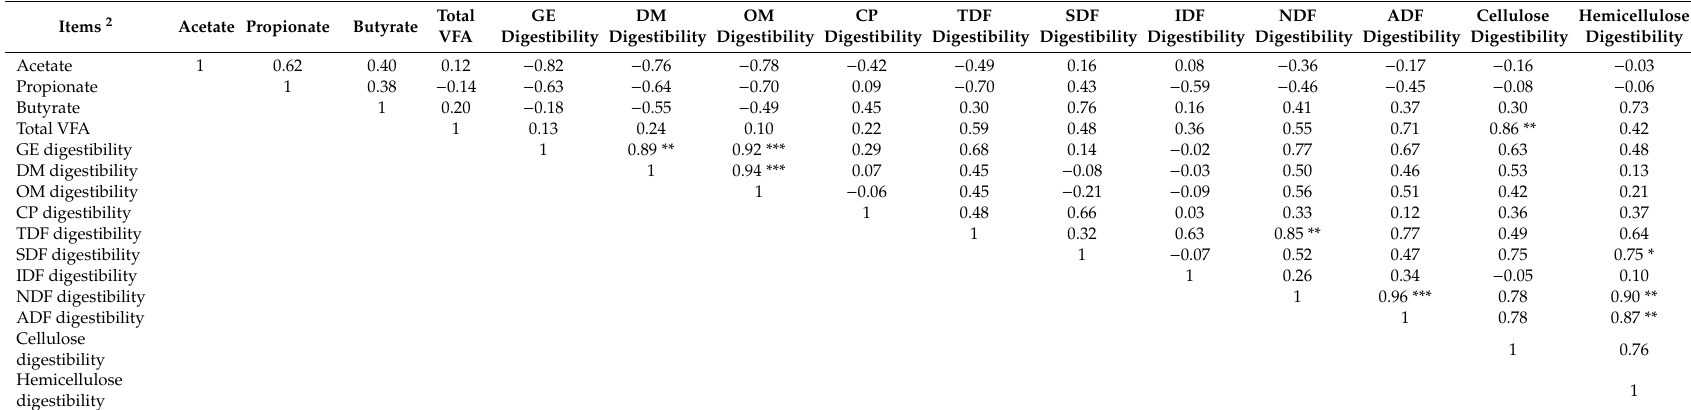
Table 6. Coe ffi cients of correlation among the AIDs of non-fibrous components or ileal fermentation of fiber components and VFA concentration in ileal digesta of pigs 1 .